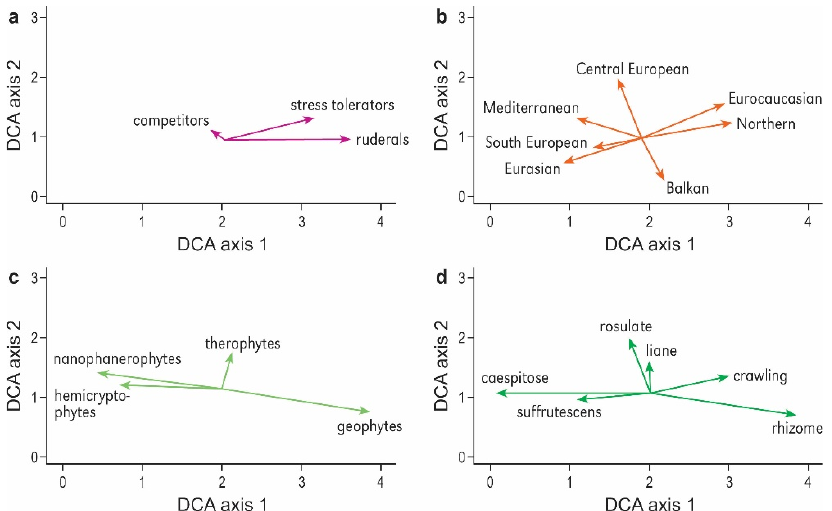
Figure 5. DCA diagram plane. For clarity only passive projection of functional strategies ( a ), chorotypes ( b ), life forms ( c ) and architecture of plants ( d ) is shown.